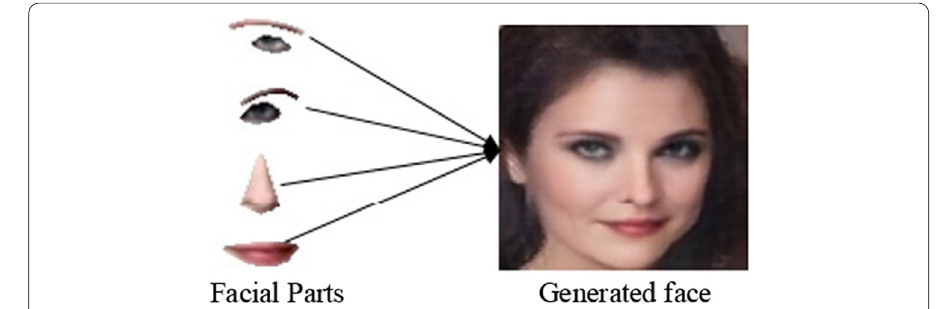
Fig. 1 A sketch of parts-based facial image